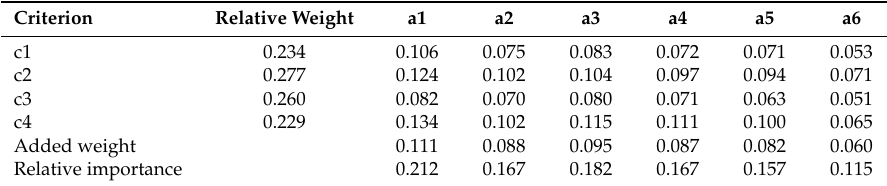
Table 17. Relationship matrix of organizational performance and project